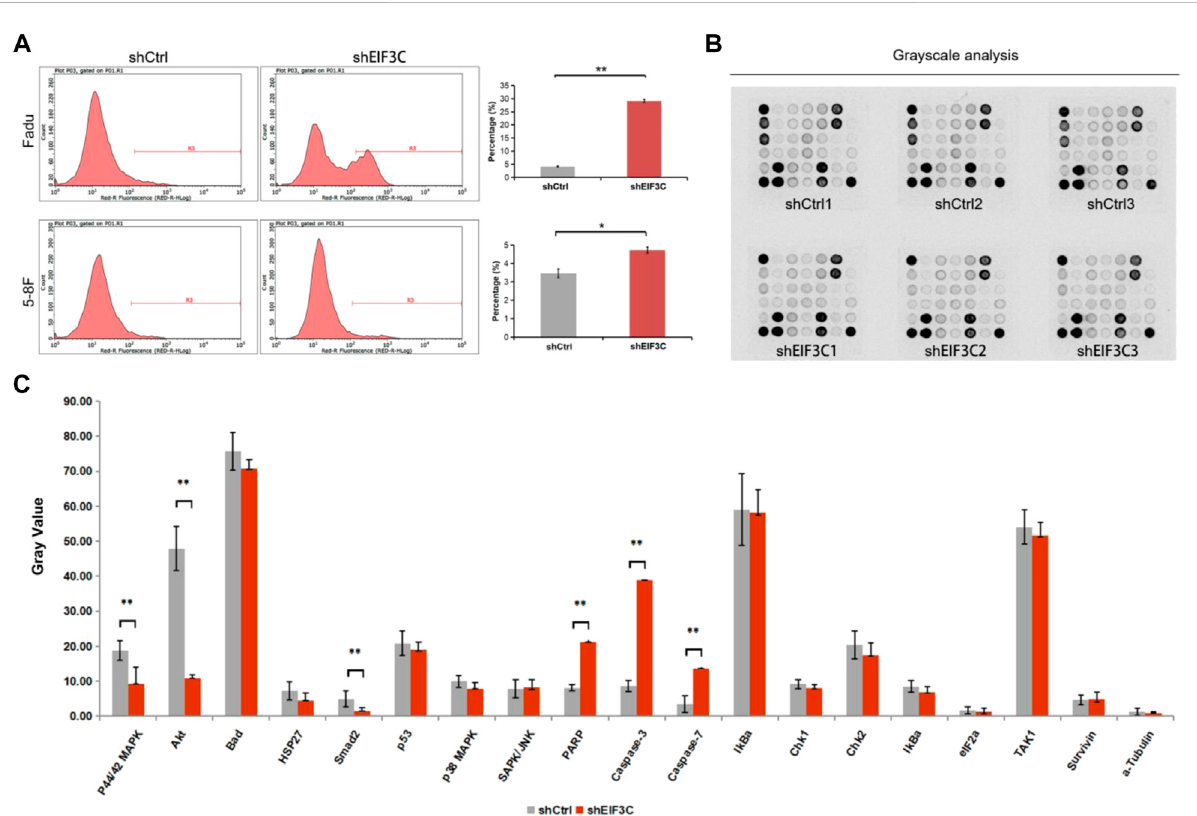
FIGURE 4 The L.v-shEIF3C promoted the apoptosis of FaDu and 5-8F cells. (A) The fl ow cytometry analysis showed that the apoptotic cells in the L.v- shEIF3C group were more than that in the L.v-shCtrl group. (B) Images were captured by exposing the slide slightly to standard chemiluminescent fi lm. (C) Pathscan sandwich ELISA was used to detect the protein expression of key genes in apoptosis-related signaling pathways, and the results showed that the expression of phospho-P44/P42 MAPK, phospho-Akt and phospho-Smad2 was decreased, the expression of cleaved-PARP, cleaved-Caspase3 and cleaved-Caspase7 was increased by L.v-shEIF3C. The data is the means ± SDs of three independent experiments. The differences were statistically signi fi cant. * p < 0.05, ** p <